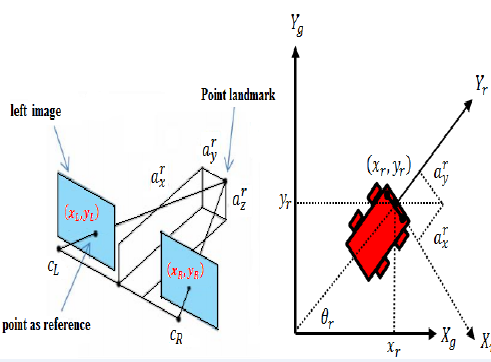
Fig. 1: Observation system